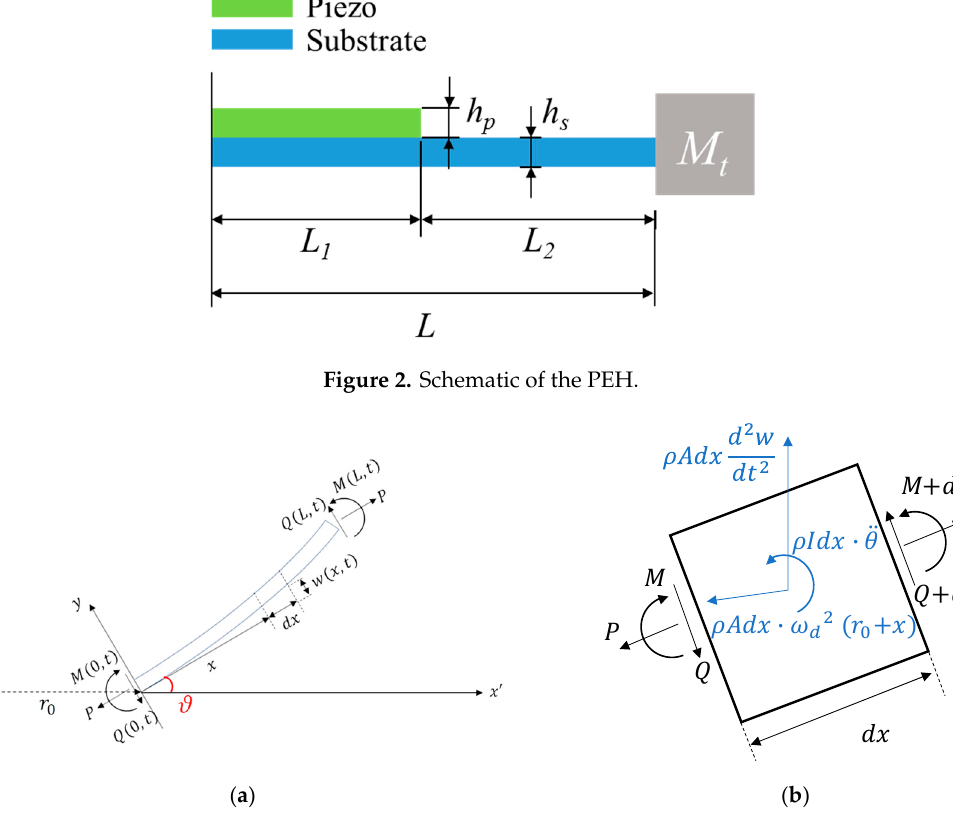
Figure 3. Force diagrams of ( a ) the whole beam ( b ) an infinitesimal element.